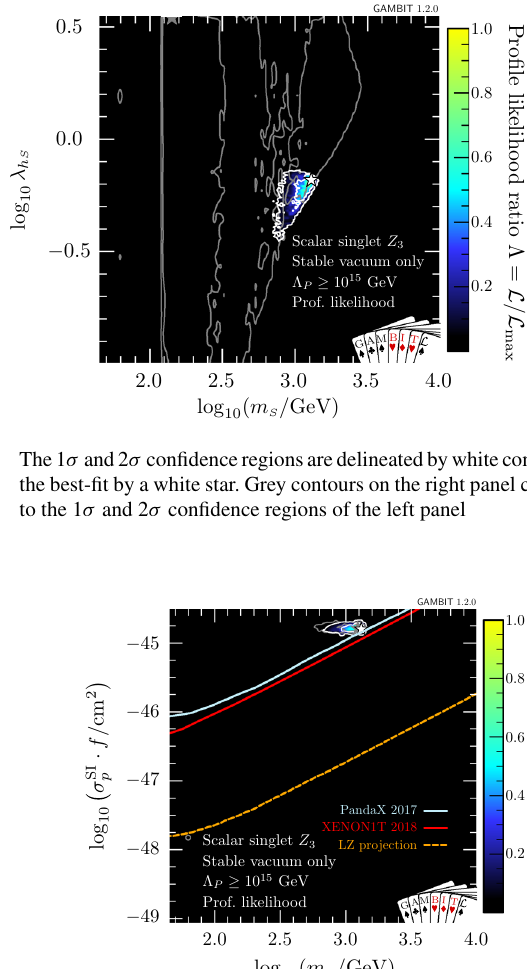
Fig. 13 As in Fig. 10, but with the added requirements of vacuum stability and perturbativity to large scales, Λ P > 10 15 GeV